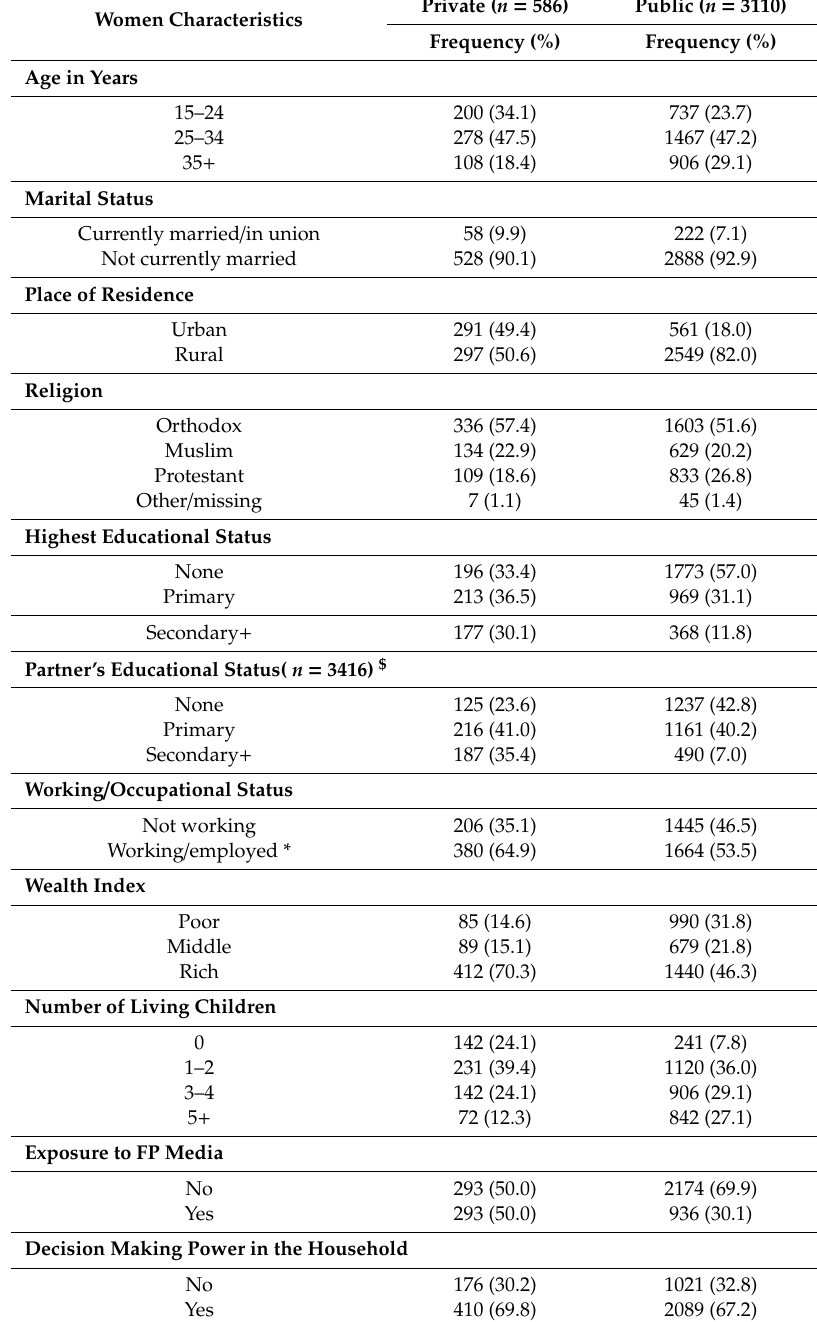
Table 2. Characteristics of women accessing FP services from public and private health facilities, EDHS 2016 ( n =